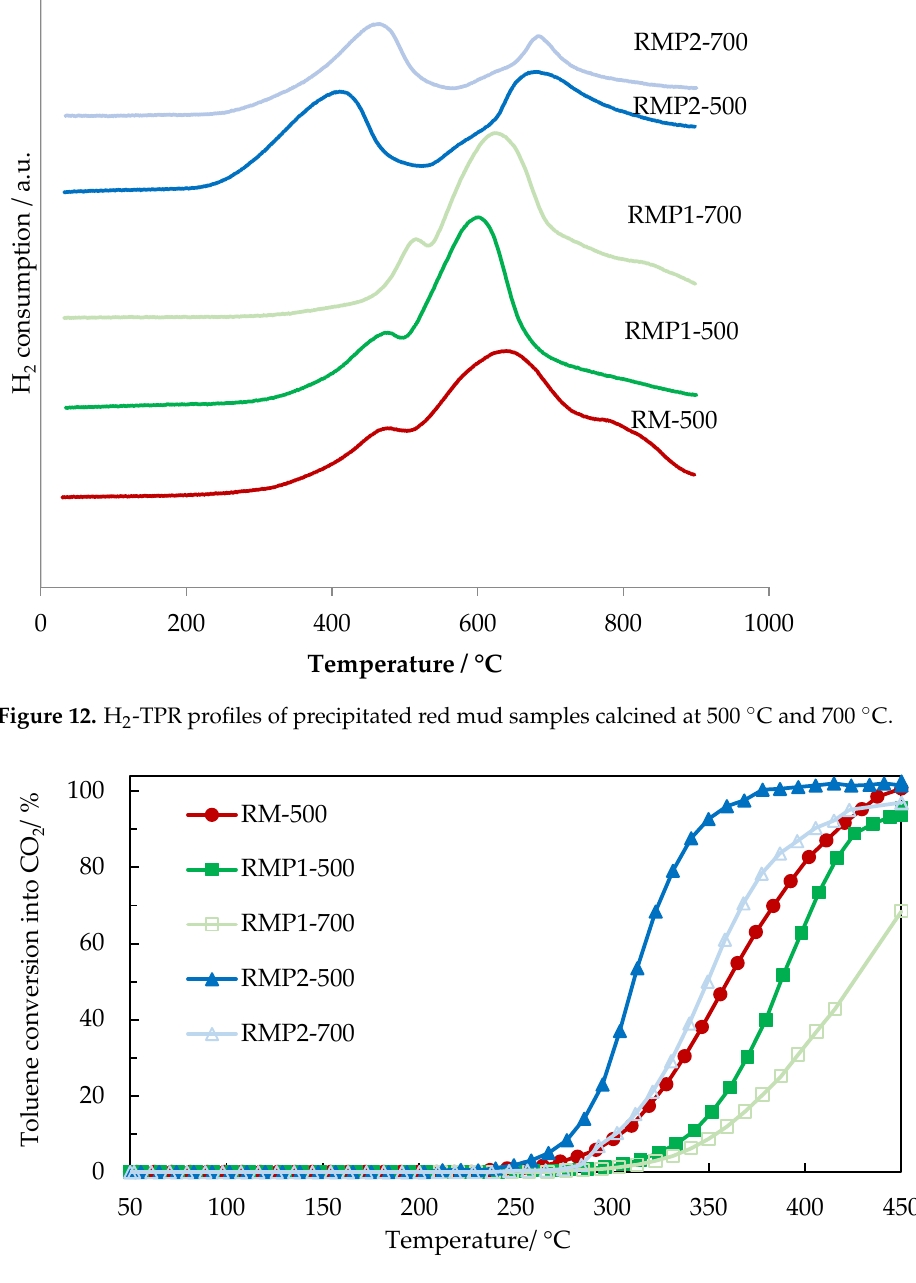
Figure 13. Toluene conversion to CO 2 as a function of the temperature in the presence of the calcined and precipitated catalysts (RM-500, RMP1-500, RMP2-500, RMP1-700, and RMP2-700). Table 8. Light-off temperature of the RM and RMP samples for toluene oxidation to CO 2 . Sample